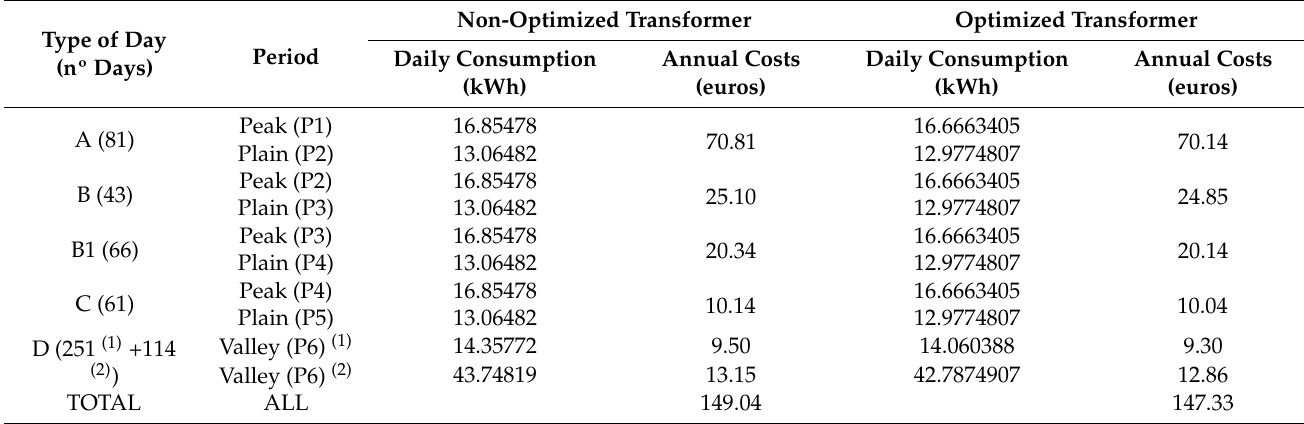
Table 12. Daily energy consumptions and annual costs of the 1000 kVA Ormazabal transformer with and without optimized operation. (1) Weekdays and (2) holidays. Type of